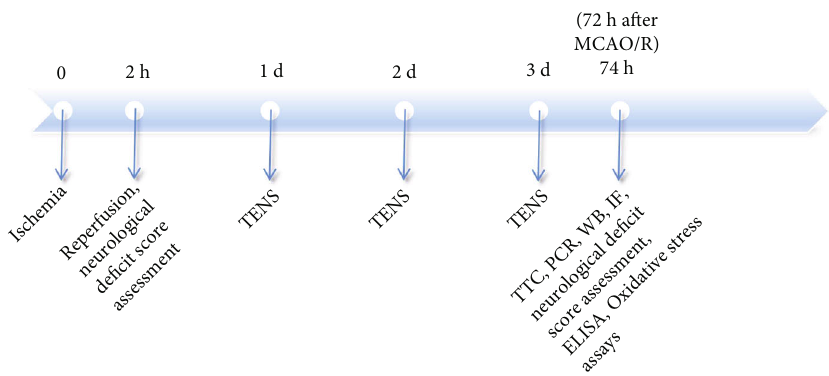
Figure 1: The experimental protocol at di ff erent time